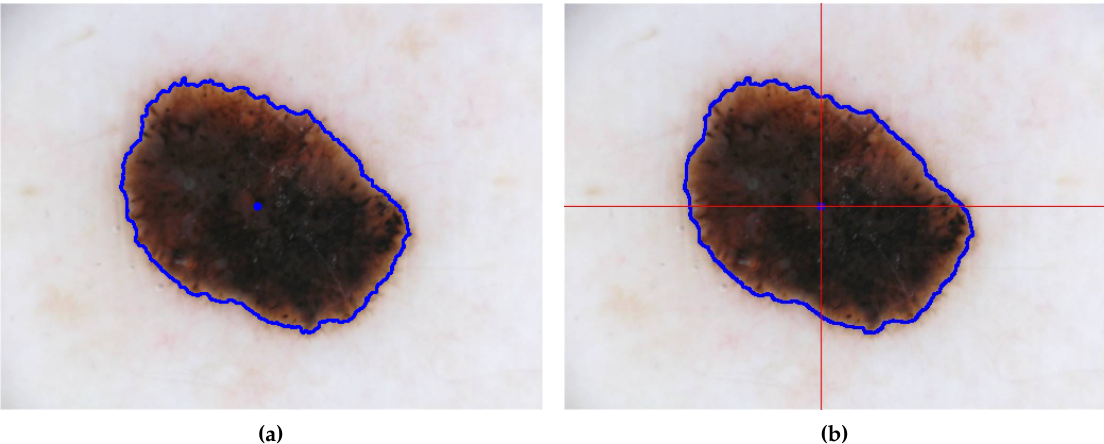
Figure 3. ( a ) Original image with the signal contour and center of mass represented by the blue dot; ( b ) Image divided in four quadrants with intersection of the axes in the center of mass.